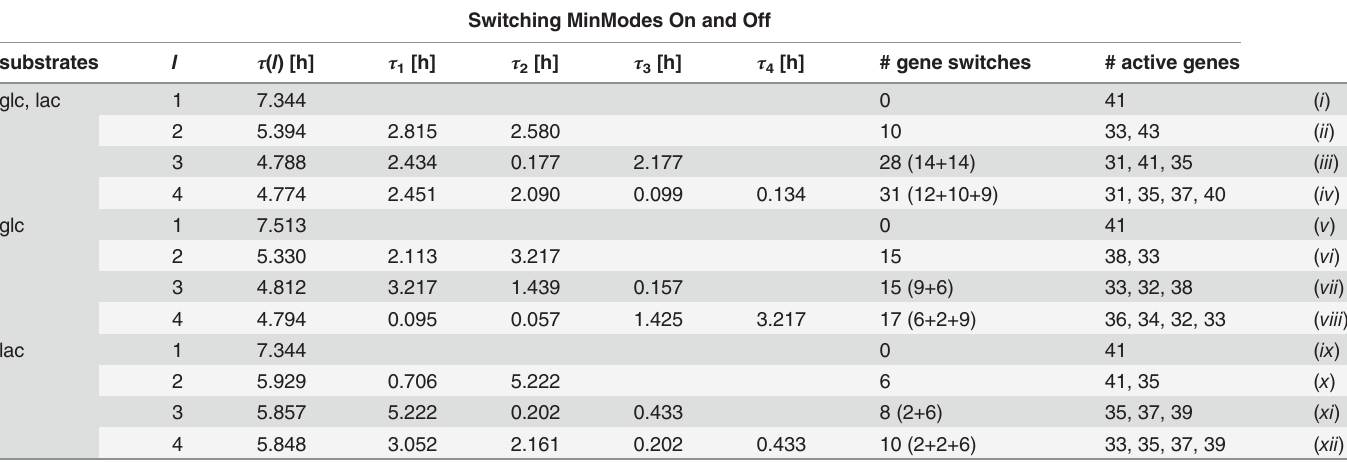
Table 3. Minimal production times in 1, 2, 3 and 4 different phases.